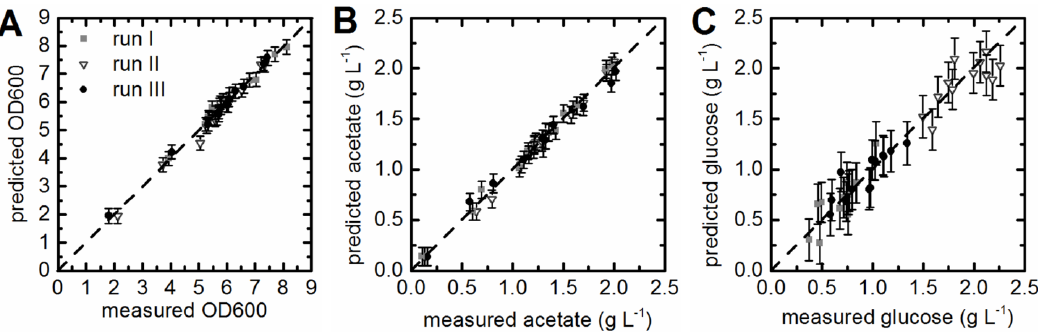
Figure 2. Prediction versus reference plots. PLS regression models were built for OD 600 ( A ), acetate ( B ), and glucose concentrations ( C ). Online and offline data of three cultivations was used for calibration and cross-validation of the PLS models. Vectorized EEMs taken at the sample points ( x -data) and the offline measured values ( y -data) were correlated. Predicted versus reference plots of the PLS models did show good correlation.